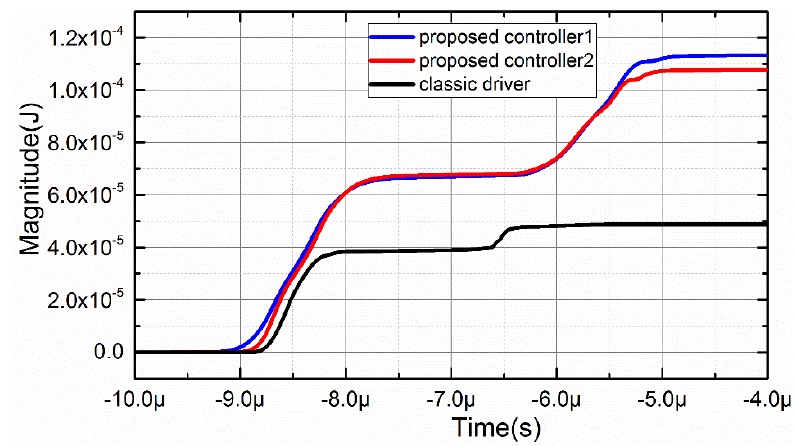
Figure 20. Switching losses comparison between the proposed controller 1, the proposed controller 2, and classical gate driver.